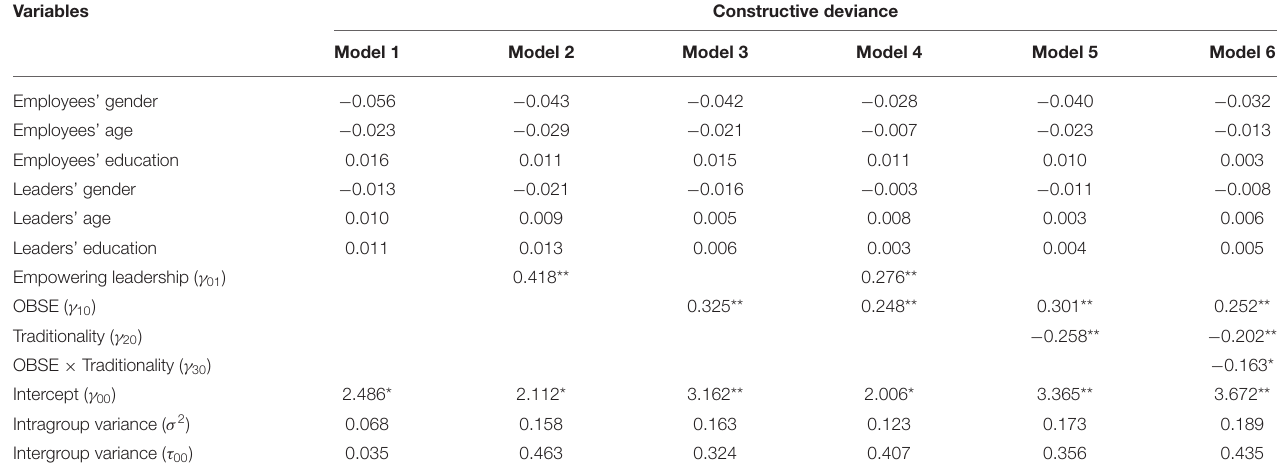
TABLE 3 | Results of hierachical regression